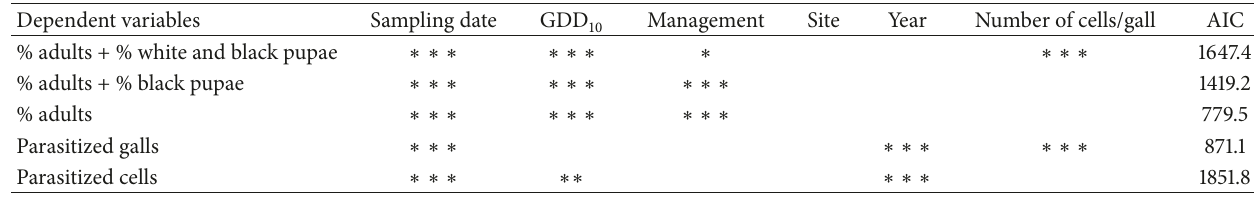
Table 6: Results of the linear generalized mixed models: for each model (row) we present the variables entered with their corresponding significance LR test. All independent variables are treated as random factors, except for the number of cells per